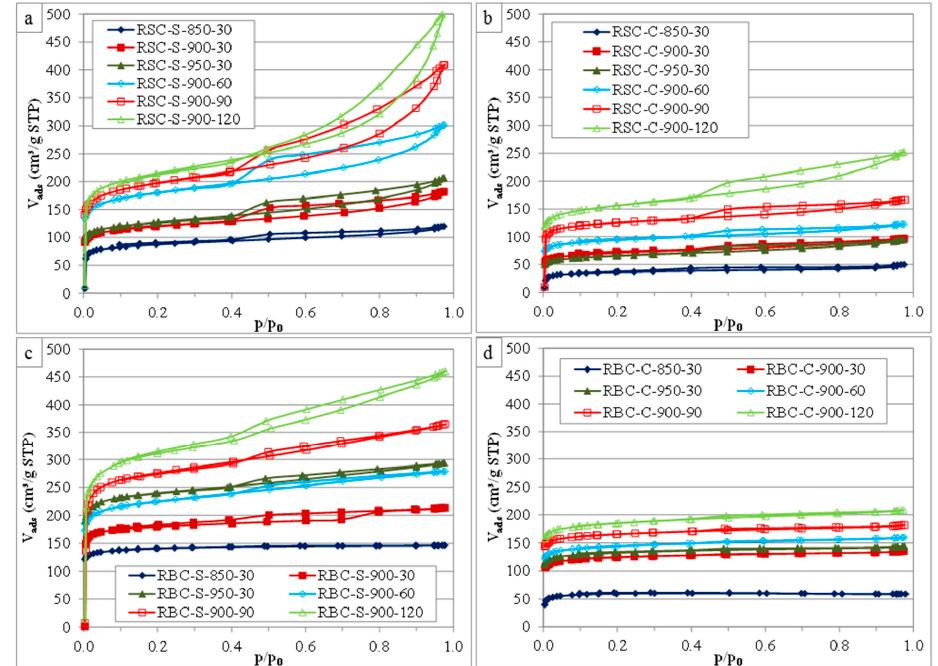
Figure 1. N 2 adsorption isotherms of ACs produced from RSC by steam ( a ) and CO 2 ( b ) activation and of ACs produced from RBC by steam ( c ) and CO 2 ( d ) activation using various activation conditions. (STP = standard temperature and